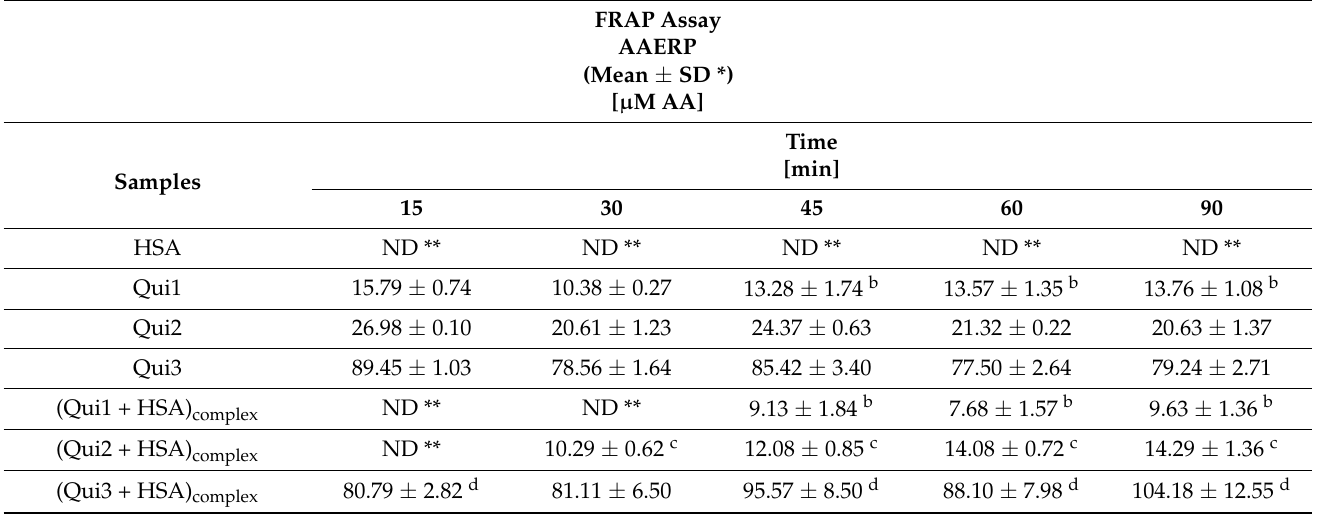
Table 11. Expected versus designated values of antioxidant activity AAERP of the tested samples; FRAP